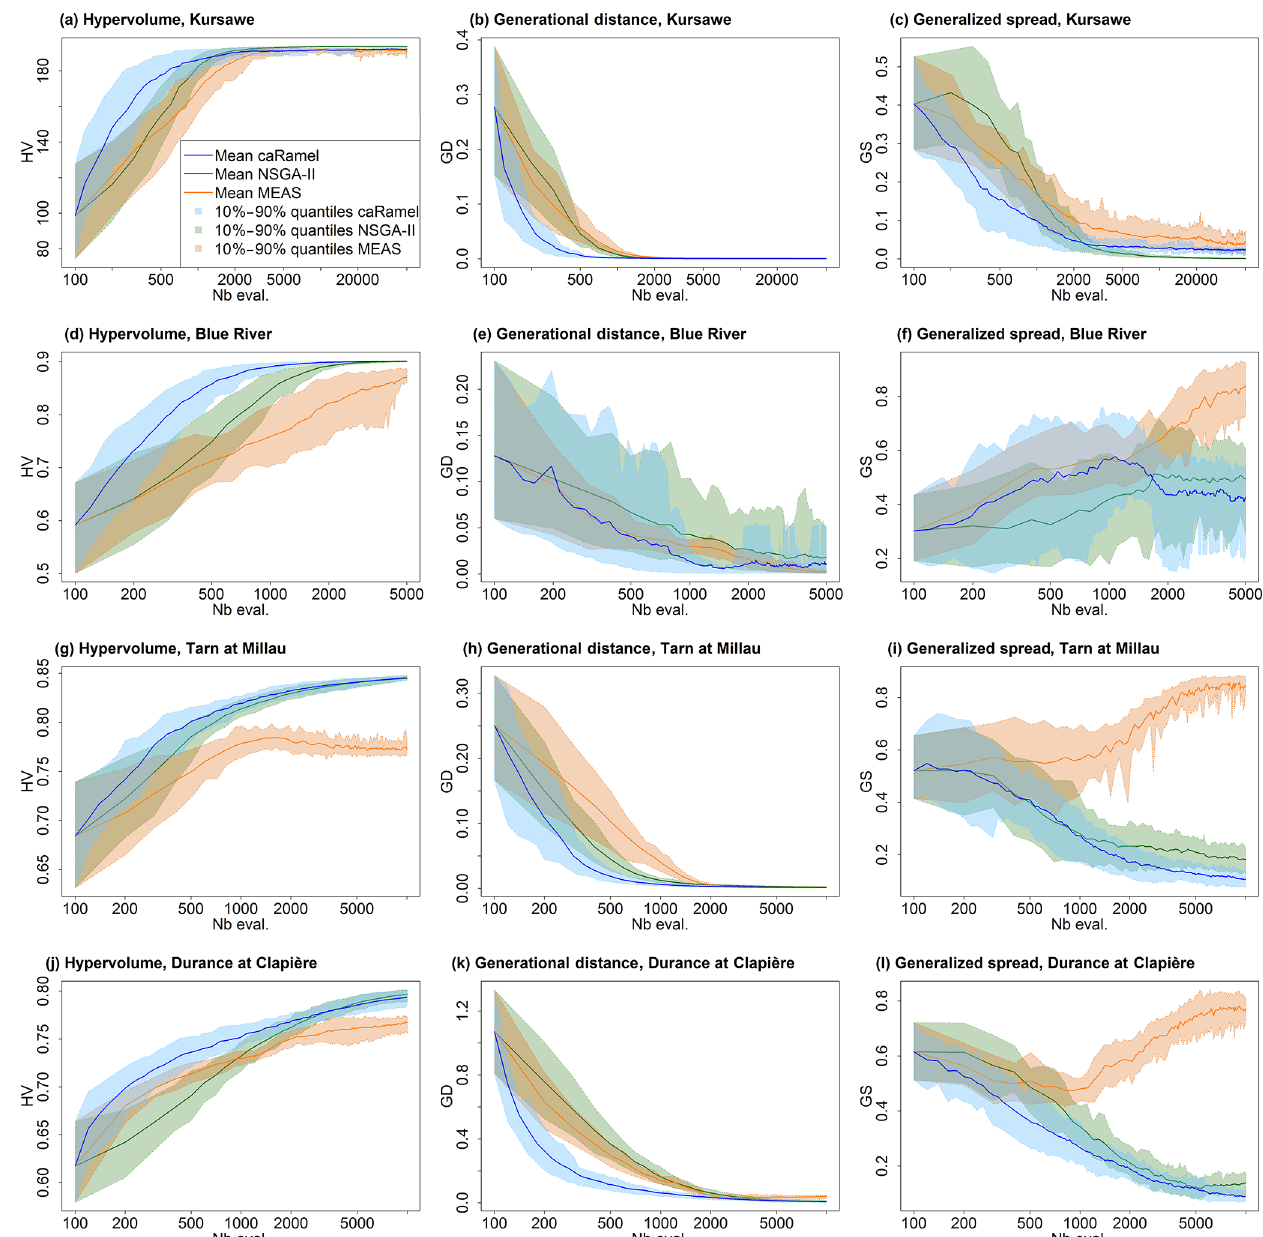
Figure 9. Metrics’ evolution over 40 optimizations with caRamel, NSGA-II and MEAS, showing the mean evolution and 10%–90% quan- tiles of the metrics with respect to the number of model evaluations: (a–c) metrics for the Kursawe test function; (d–f) metrics for the GR4J calibration of at Nourlangie Rock; (g–i) metrics for the MORDOR-TS calibration of Tarn at Millau; (j–l) metrics for the MORDOR-TS calibration of Durance at La